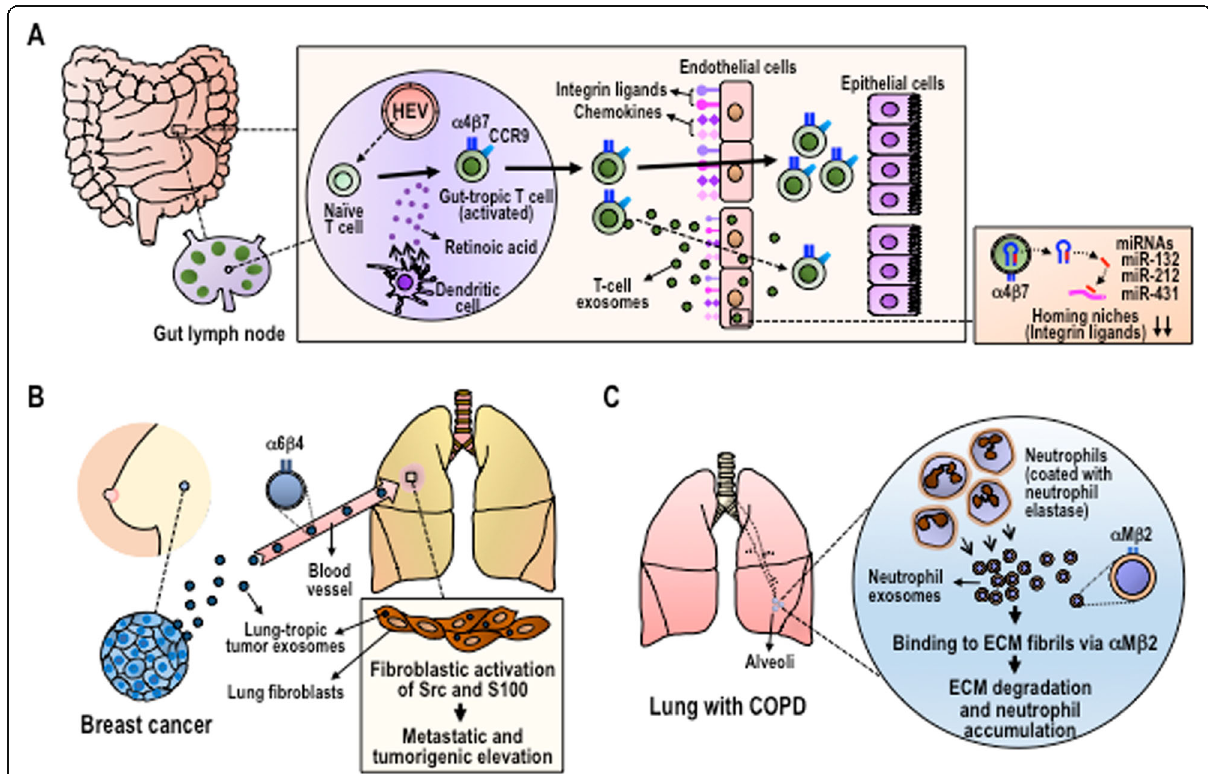
Fig. 1 Integrin-targeted exosome trafficking to vascular endothelial cells and tissue ECM, which leads to the remodeling of cancer and immune cell homing niches. ( a ) Integrin α 4 β 7-expresing T cell exosomes target HEVs in the gut, where they diminish homing niches by microRNAs-132, 212, and 431. ( b ) Integrin α 6 β 4-expresing breast cancer exosomes target the laminin ECM in the lung, where they cultivate the homing niches by eliciting inflammation through Src and S-100 activation. ( c ) Integrin α M β 2-expresing neutrophil exosomes target multiple ECMs in the lung, thereby damaging alveoli structures and promoting further neutrophil accumulation by sustained neutrophil elastase proteolytic